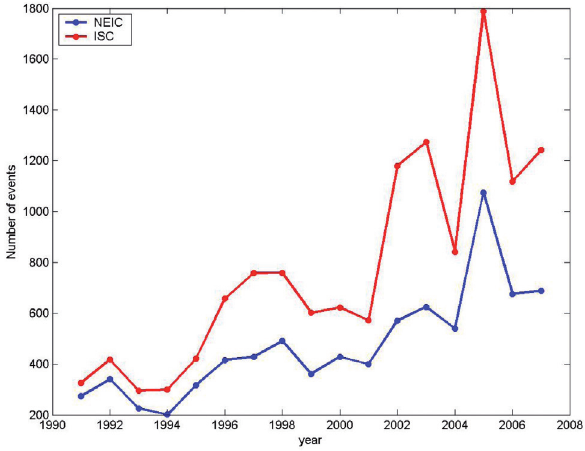
Figure 3. Changing of total amount of events by years for Central Asia territory in NEIC and ISC catalogues.